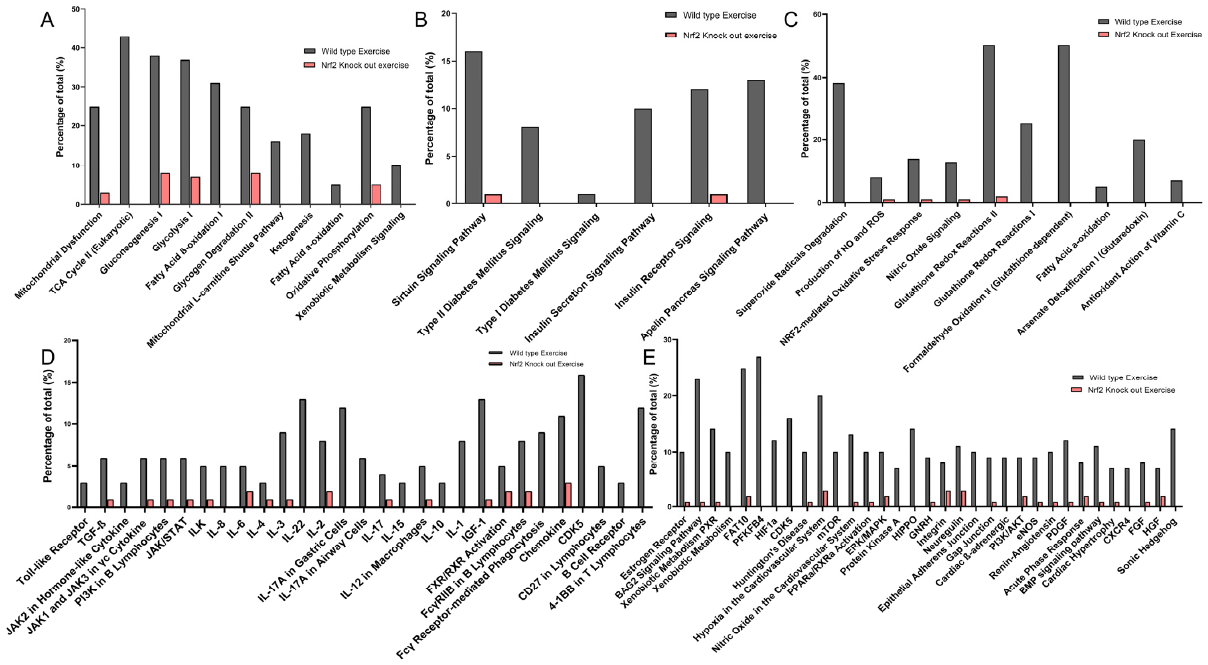
Figure 5. Percentage protein expression in pathways related to ( A ) energy production, ( B ) insulin signaling, ( C ) redox status, ( D ) immune signaling, and ( E ) other physiological pathways in WT-ExT mice in comparison to Nrf2-KO mice after ExT. Gray bars indicate proteins upregulated in WT mice and red bars indicate their downregulated expression levels in Nrf2-KO